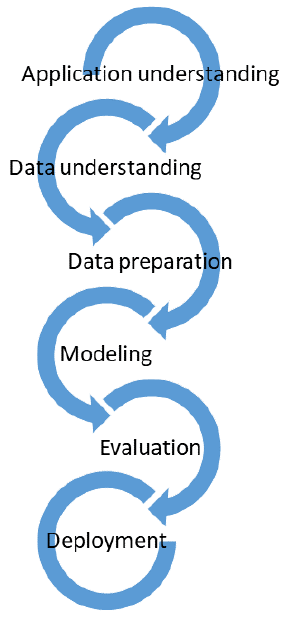
Figure 1. Process model for application of AI in